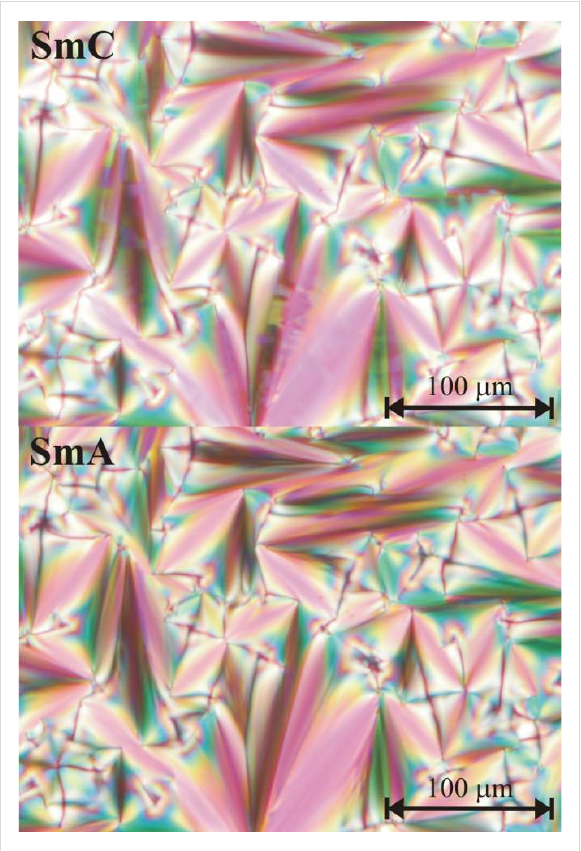
Figure 6: Textures of the mixture with 65% PhP14 in 2PhP as observed in the polarizing microscope. The upper part shows the broken fan-shaped texture of the SmC phase at T = 75 °C. In the lower part the fan-shaped texture of SmA is observed at T = 86